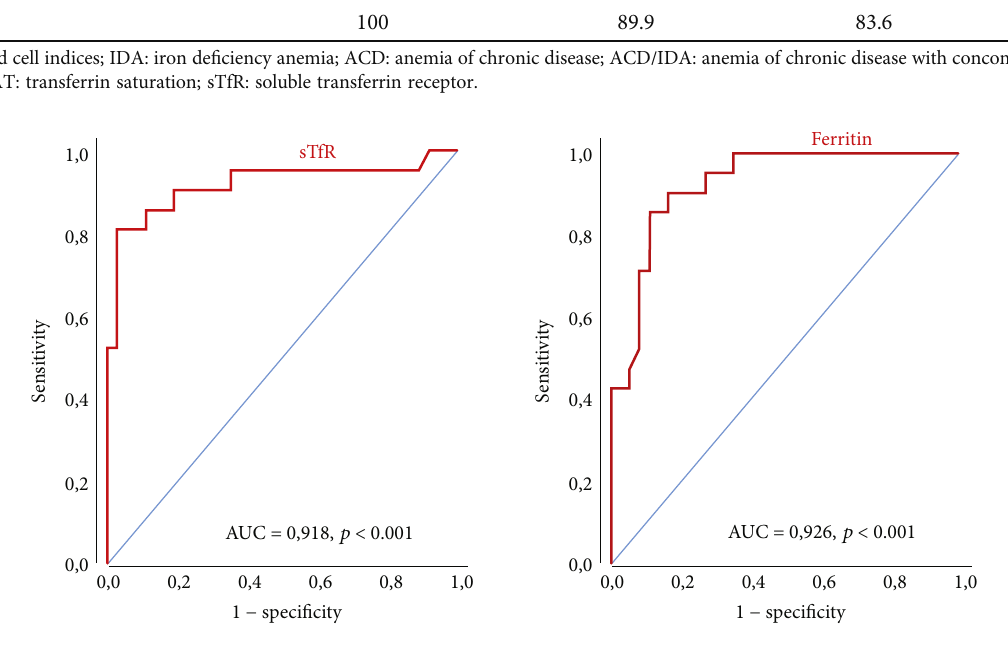
Figure 2: ROC curves for sTfR and ferritin in the diagnosis of iron de fi ciency, i.e., IDA or ACD/IDA, in patients with rheumatoid arthritis with low in fl ammatory activity. IDA: iron de fi ciency anemia; ACD: anemia of chronic